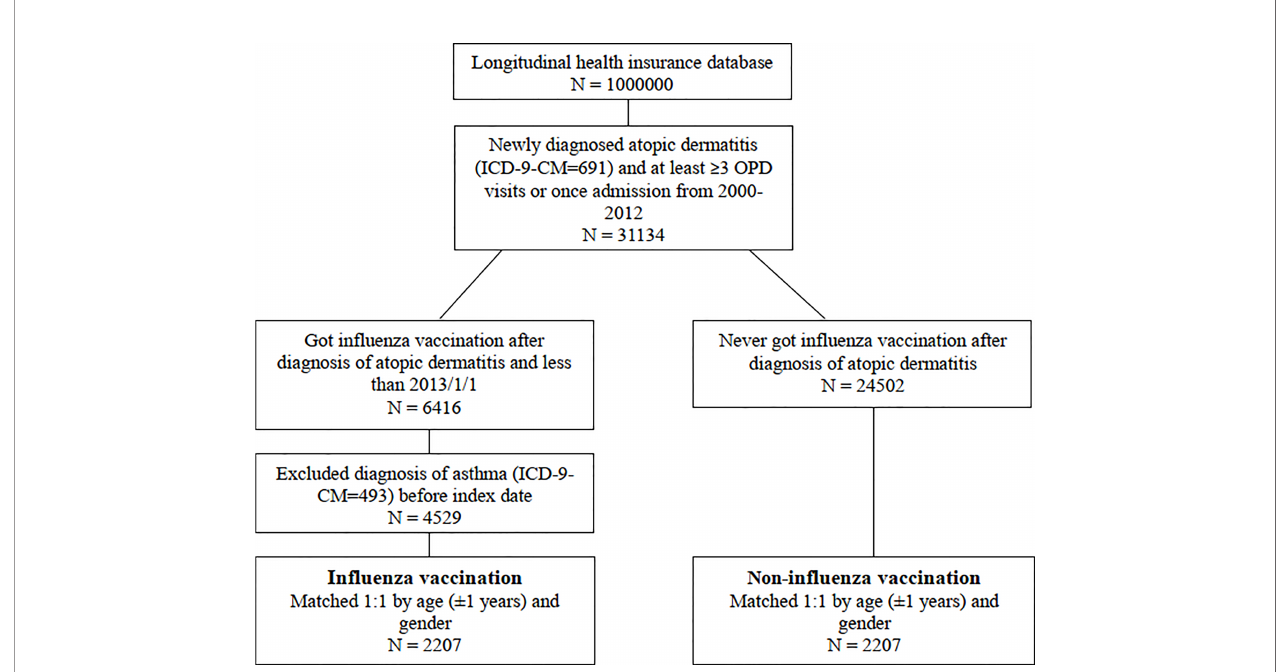
FIGURE 1 | Flowchart of subject's enrollment with and without in fl uenza